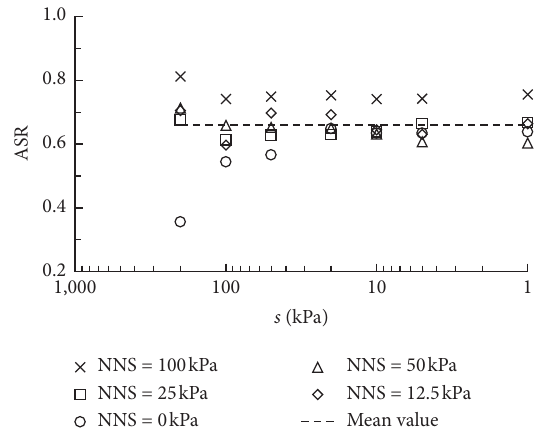
Figure 12: Variation of anisotropic swelling ratio with matric